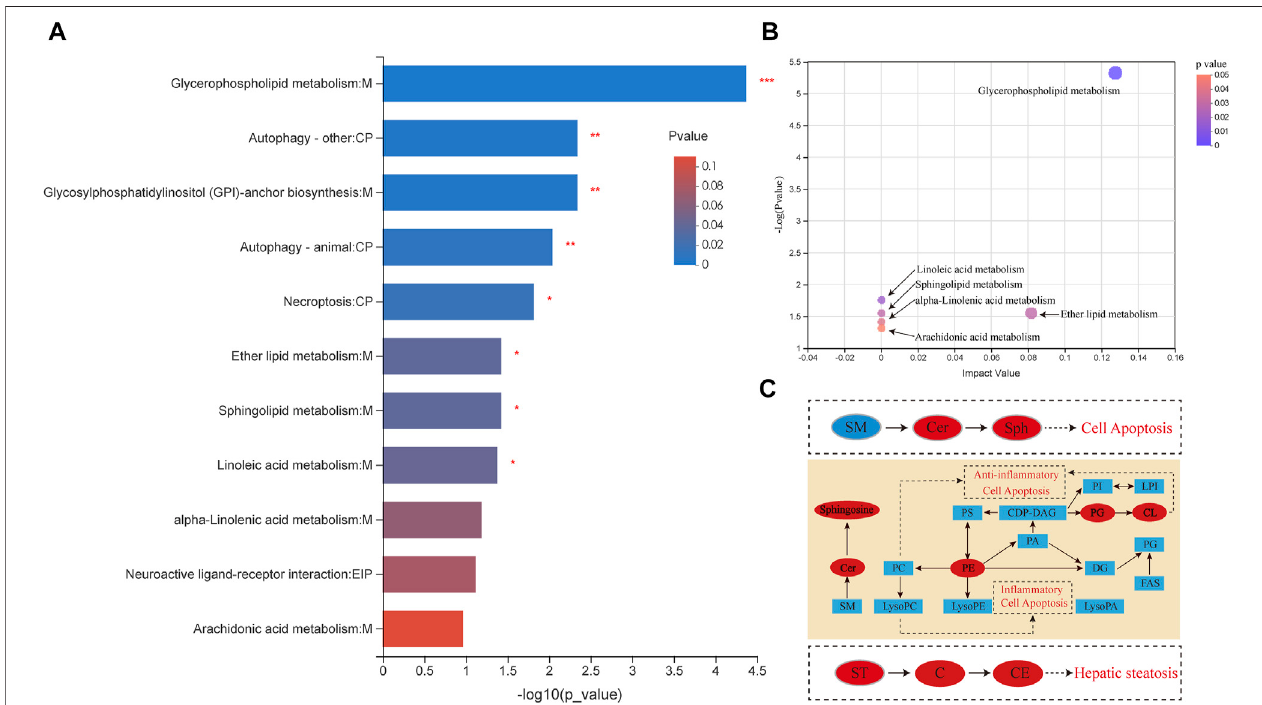
FIGURE 4 | Different lipid species are associated with metabolism (A) Pathway enrichment analysis of lipid metabolites by KEGG. Results include α -linolenic and linoleic acid metabolism, arachidonic acid metabolism, glycerolipid metabolism, fatty acid extension in mitochondria, fatty acid biosynthesis, fatty acid metabolism, steroidbiosynthesis,and bileacidbiosynthesis (* p < 0.05, ** p < 0.01comparedwiththecontrolgroup) (B) Pathwaytopologyenrichmentanalysisoflipidmetabolitesby KEGG (C) Network of changes in potential biomarkers of the AcOEtE group compared to the Control group. Red, upregulated biomarkers; blue, downregulated